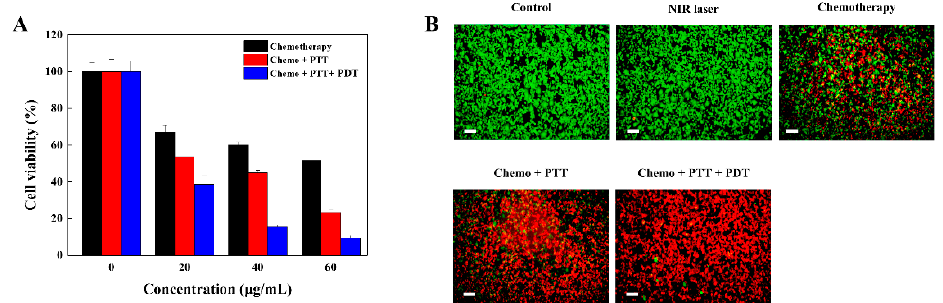
Figure 7. ( A ) Quantitative viability of the B16F10 cells treated with the ID@MOS-Fc-CDHA nanocomposites with or without the NIR laser irradiation (808 nm, 2 W/cm 2 , and 5 min) for the chemo-, photothermal, and photodynamic amulti-modal therapies. ( B ) Fluorescent images of the live/dead assay in the B16F10 cells after 60 μ g/mL of the ID@MOS-Fc-CDHA nanocomposites with or without the NIR laser irradiation (808 nm, 2 W/cm 2 , and 5 min) for the synergistic therapeutic effects via the chemo-, photothermal, and photodynamic therapies. The cells were stained with calcein AM (live cells, green) and ethidium homodimer-1 (dead cells, red). Scale bars are 50 μ m.